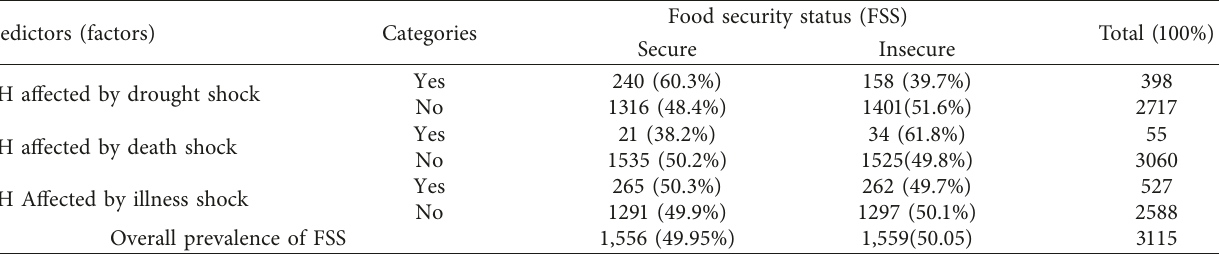
Table 3: Association of household food security status among shock variables that households faced 12months prior to the survey visit in rural